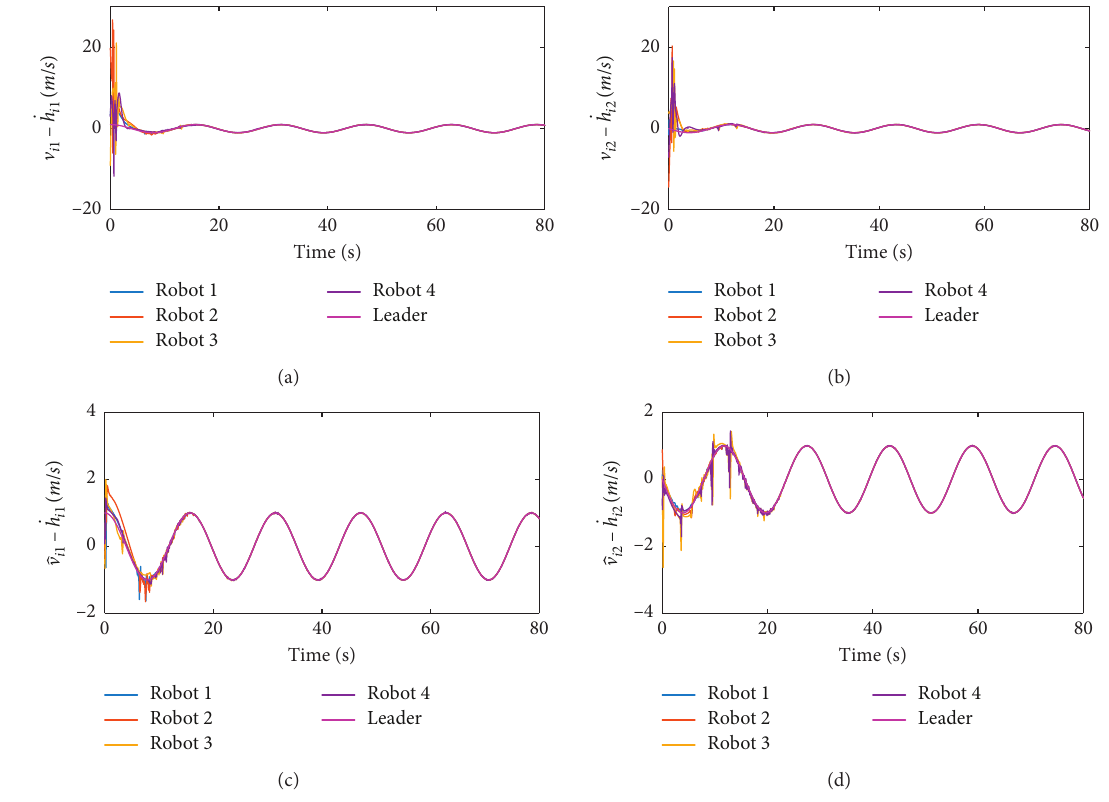
Figure 6: Evolution of v